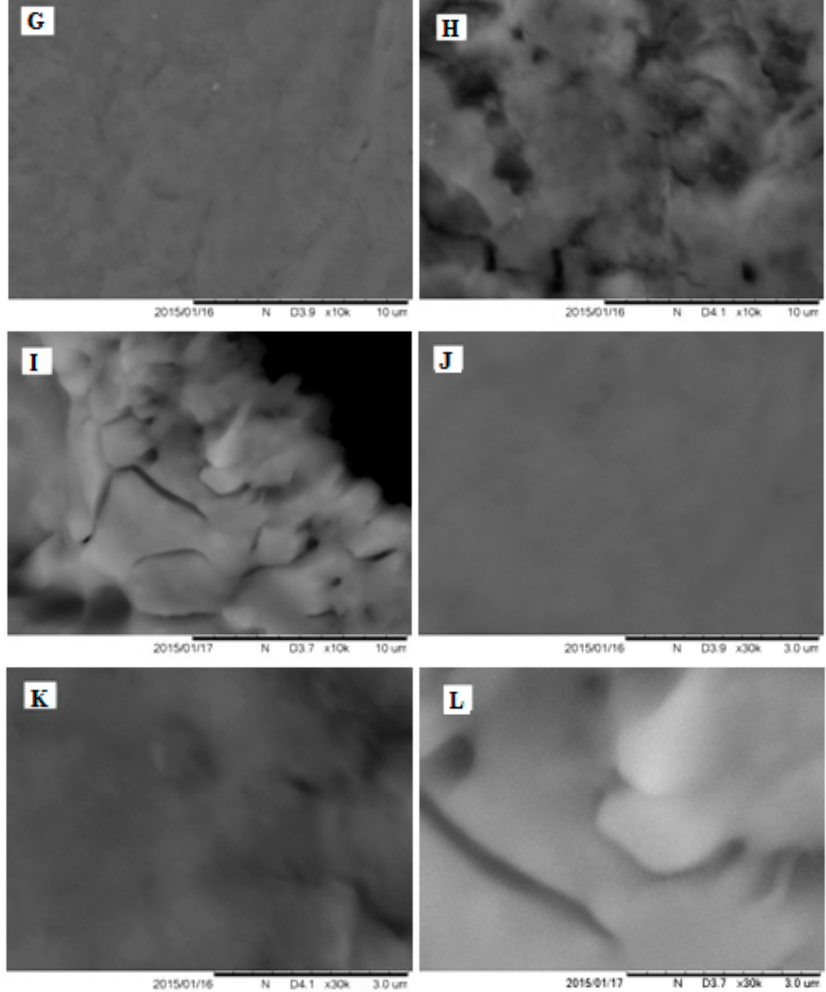
Figure 4. SEM images of GR electrodes: ( A , D , G , J ) bare, ( B , E , H , K ) modified with poly-PQ applying 1 potential cycling, ( C , F , I , L ) modified applying 3 cycles, at magnifications of: ( A – C ) 50×, ( D – F ) 1000×, ( G – I ) 10,000×, ( J – L ) 30,000× and scale bar lengths are respectively 1 or 2 mm, 100 μ m, 10 μ m and 3 μ m.